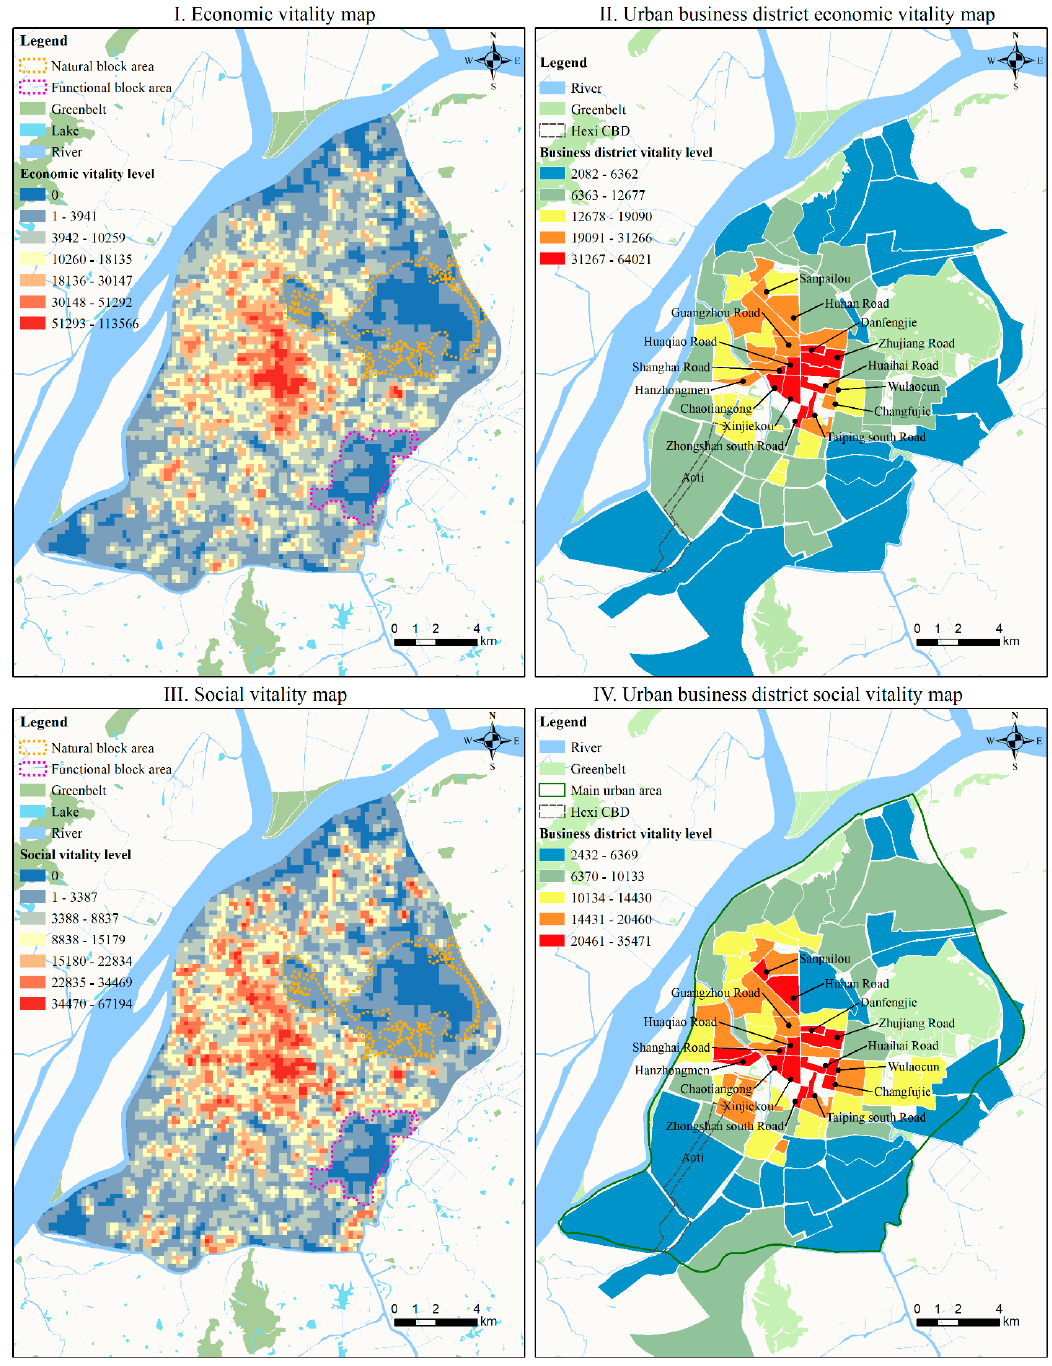
Figure 5. Distribution of economic and social vitality in the study area ( I , III ) and distribution of economic and social vitality in the business districts ( II , IV ). The vitality intensity is graded using the natural breaks method [56], and the color from dark blue to red indicates the change in the vitality level from weak to strong, the unit is person/km 2 .